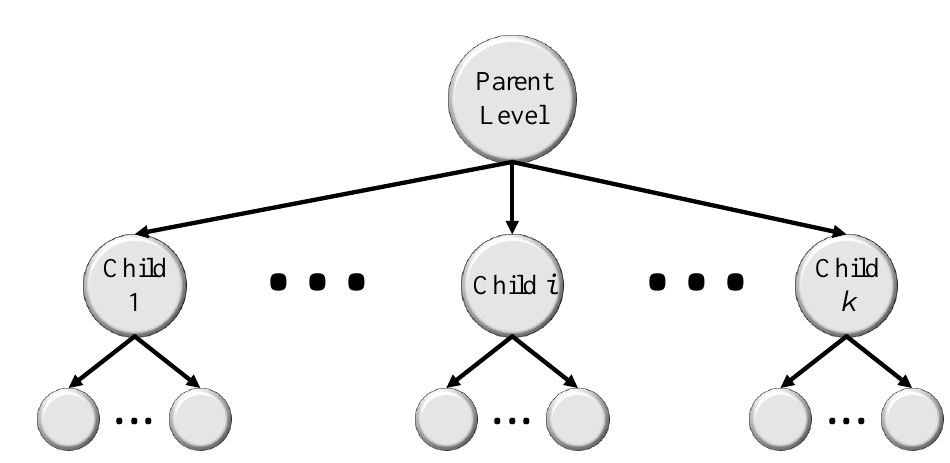
Figure 1. HMIC: Hierarchical Medical Image Classification.